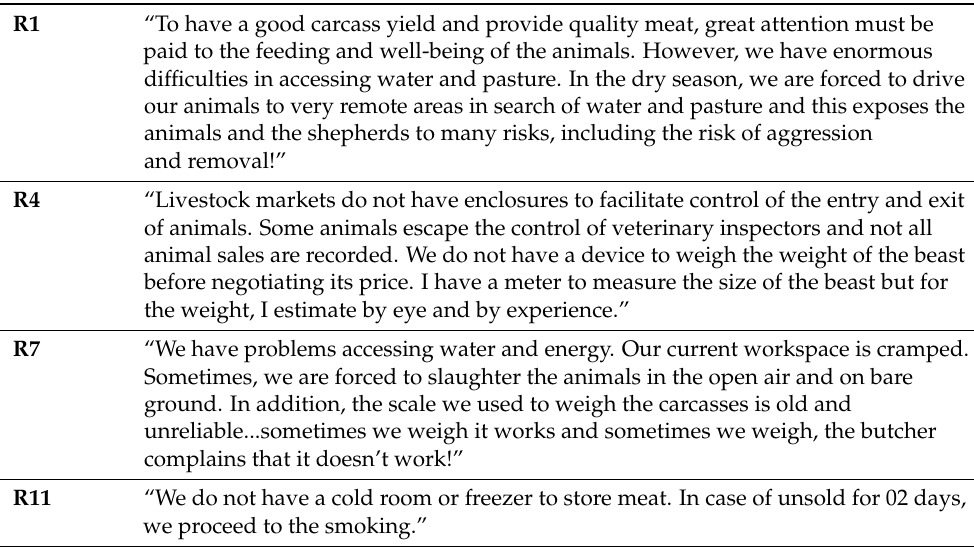
Table 6. Illustrative verbatim of the technical difficulties encountered by meat SC